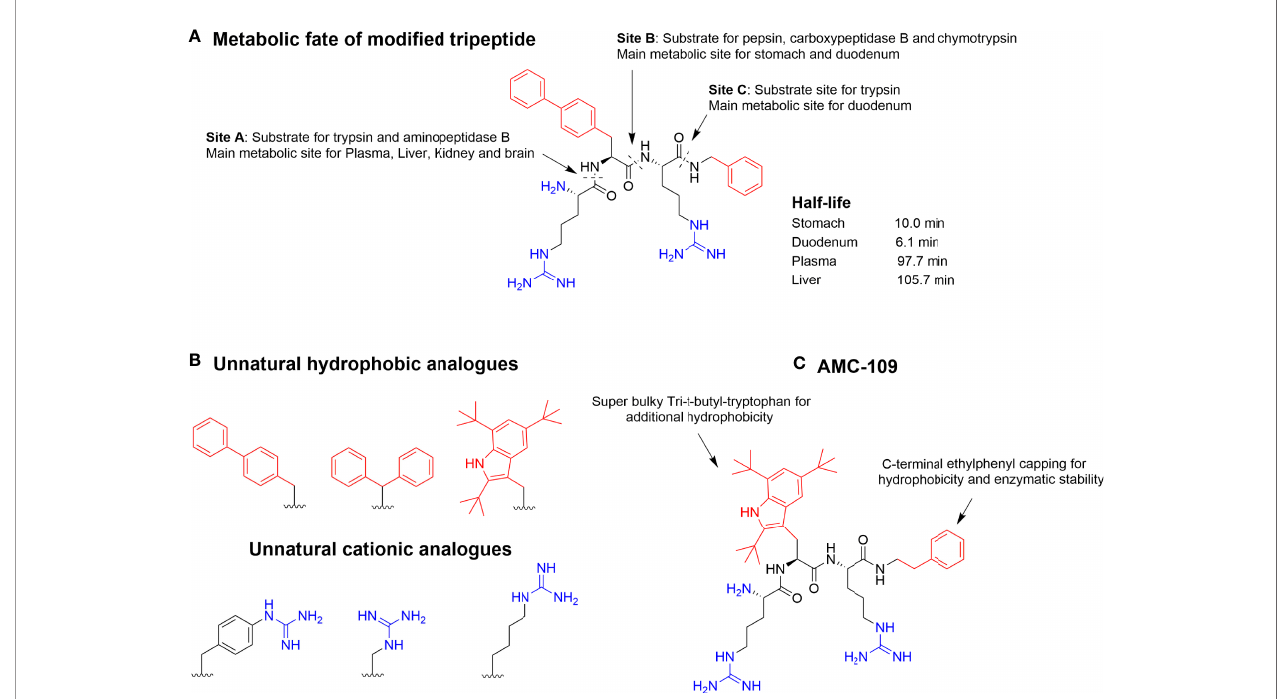
FIGURE 4 | (A) Metabolic susceptibility of a short, modi fi ed, and highly active antimicrobial tripeptide in selected key metabolic compartments despite incorporation of bulky unnatural amino acids (47). (B) Incorporation of optimized unnatural cationic and hydrophobic amino acids can be used to steer the metabolic stability together with different C-capping strategies. (C) Optimized lead AMC-109 (previously LTX-109) currently developed by Amicoat AS (Norway) for the eradication of microbial bio fi lms